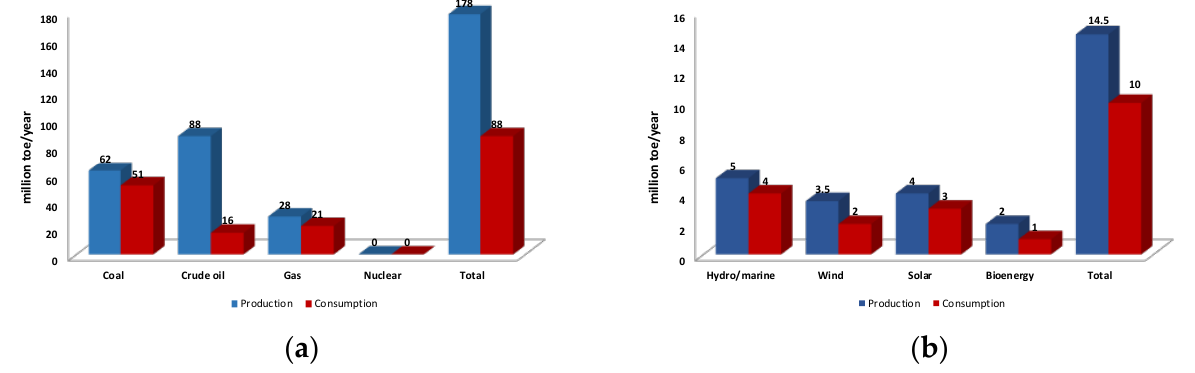
Figure 1. Primary crude ( a ) and renewable ( b ) energy production and consumption in Kazakhstan in 2021. Data for figure from [14,35].